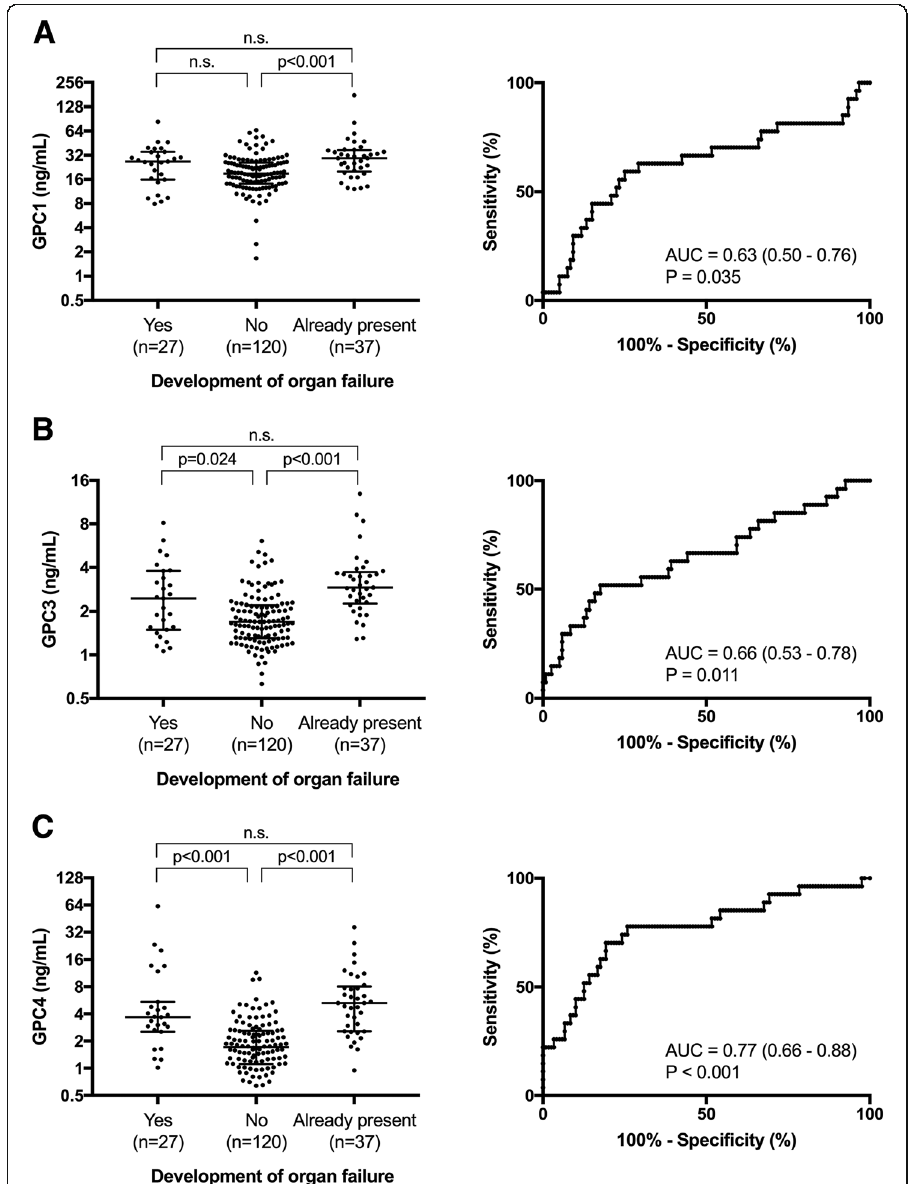
Fig. 3 Plasma glypicans are predictive of the development of organ dysfunction. Patients were divided into groups of those who developed organ failure after enrollment, those who never developed organ failure, and those who already had organ failure on enrollment. Plasma levels of a GPC 1, b GPC 3, and c GPC 4 were compared between groups using a Kruskal-Wallis test followed by Dunn ’ s multiple comparisons test. ROC curves were generated to examine the ability of each glypican to predict the development of organ failure in patients who did not already have organ failure upon enrollment. Area under the curve (AUC) and 95% confidence intervals are indicated on each